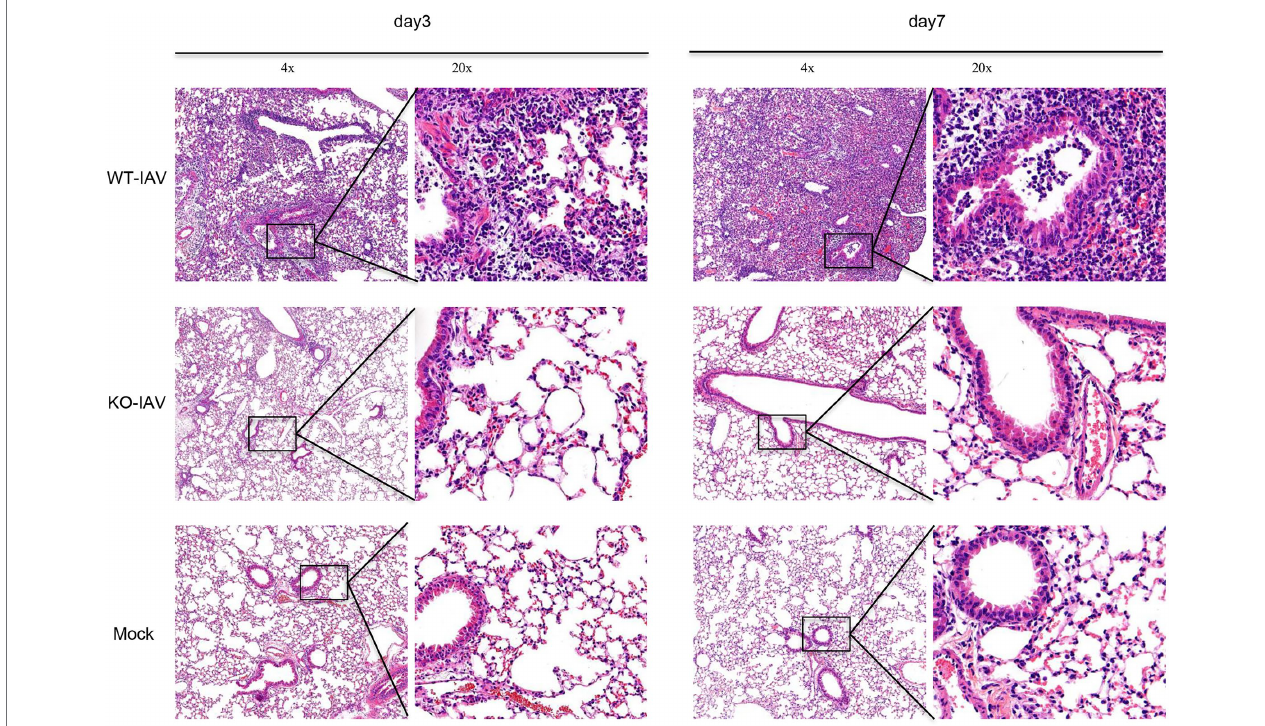
FIGURE 8 | IL16 deficiency alleviates lung injury after IAV infection. Seven-week-old male WT and IL16 KO mice were intranasally infected with PR8 virus (8,000 PFU), and control mice received mock inoculation with PBS. Lungs from each infected mouse were isolated on day 3 and day 7 post-infection and fixed for subsequent H&E staining. Pulmonary histological images were taken using a microscope at resolutions of 4×, 20× magnification. Data shown are representative of two independent experiments; n = 5 per group per